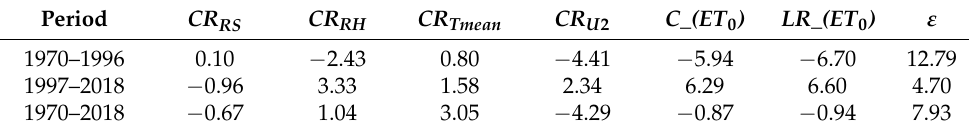
Table 2. The contribution rate of climate factors to ET 0 in different periods (%).